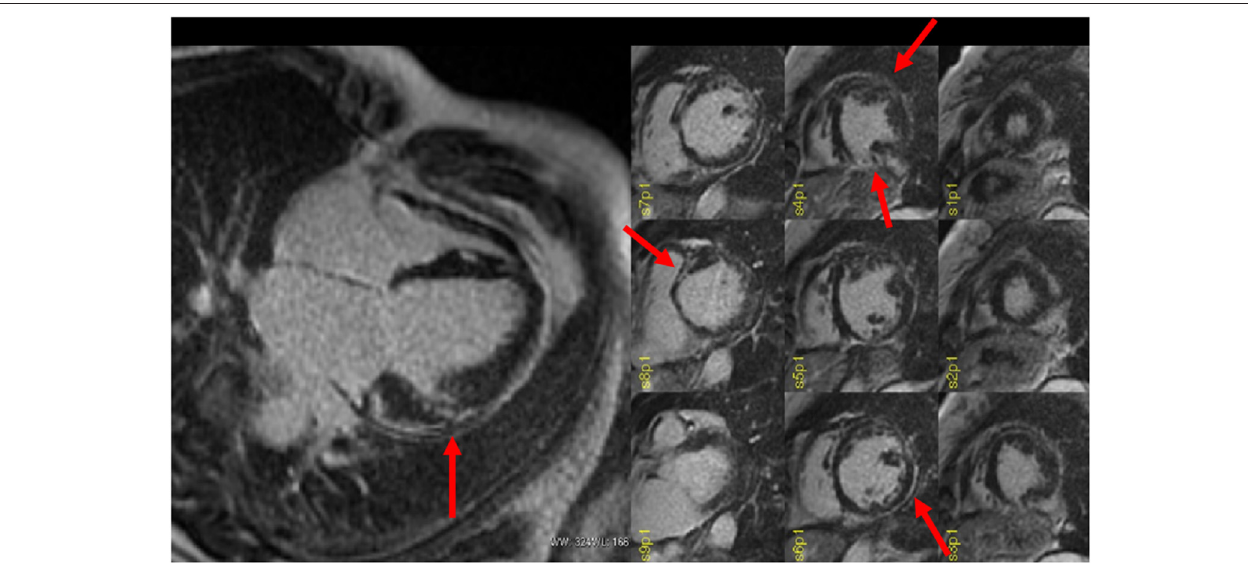
FIGURE 2 | Late gadolinium enhancement (LGE) MRI images obtained in a patient with a previous history of myocarditis and with a recent history of hemodynamically stable sustained ventricular tachycardia (VT) scheduled for ablation procedure. The four-chamber (left) view shows the presence of a focal LGE area on the mid-ventricular segment of the antero-lateral wall (almost transmural). Short-axis images (right) show the real extent of LGE that also encompasses the inferior and lateral left ventricular (LV) walls (sub-epicardial), the antero-septal wall (midwall), and the distal anterior segment. Courtesy of Dr. Giovanni Donato Aquaro, Fondazione Toscana Gabriele Monasterio, Pisa, Italy.